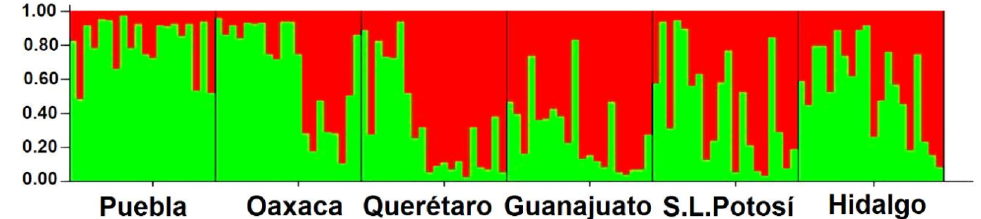
Figure 3. Population structure of 120 samples of B. veronicifolia for K = 2. Each vertical bar corresponds to a single sample and color proportion indicates a cluster produced by Structure 2.3.4